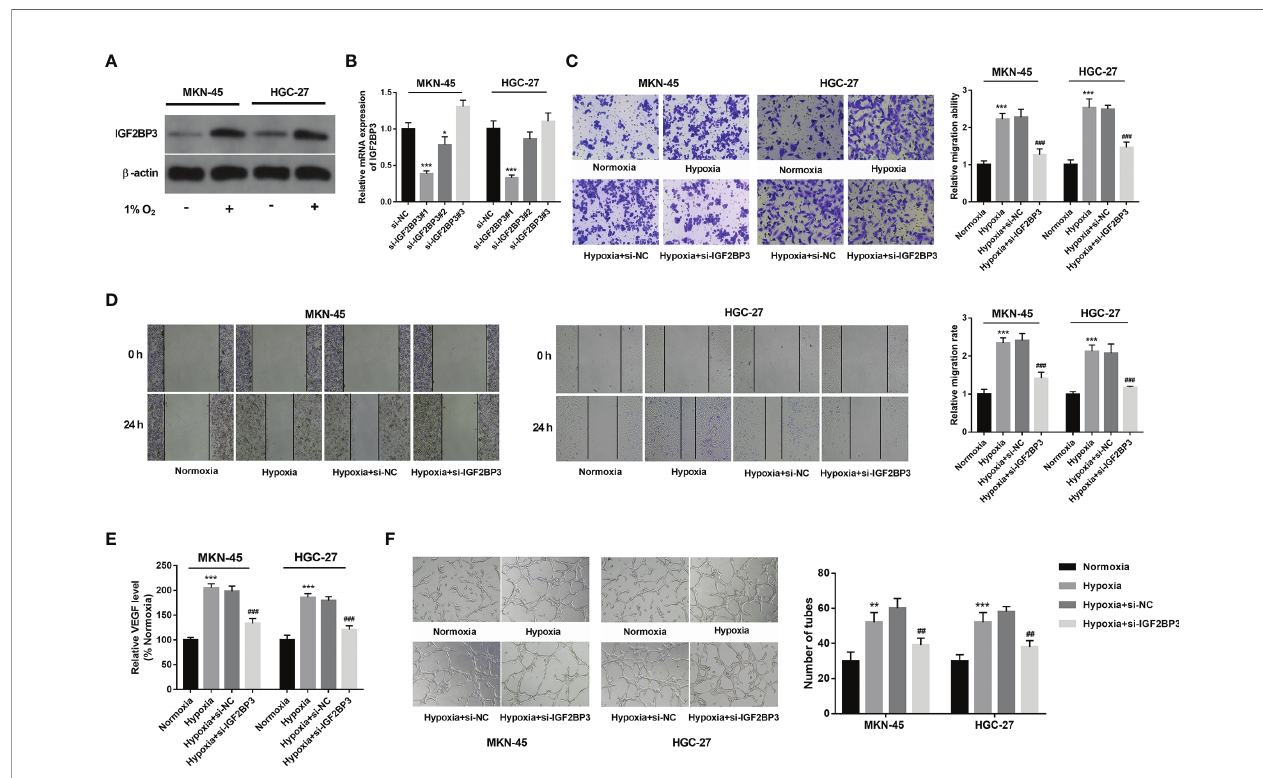
FIGURE 2 | IGF2BP3 knockdown hampered hypoxia-induced cell migration and angiogenesis in SC. (A) MKN-45 and HGC-27 cells were cultured in normoxic or hypoxic conditions for 24 h Next, the IGF2BP3 protein level was measured by western blot assay. (B) MKN-45 and HGC-27 cells were transfected with si-NC, si-IGF2BP3#1, si-IGF2BP3#2, or si-IGF2BP3#3. Next, the IGF2BP3 mRNA level was measured by RT-qPCR assay at 48 h after transfection. (C – F) MKN-45 and HGC-27 cells were transfected with si-NC or si-IGF2BP3#1 for 48 h and then maintained in hypoxic conditions for another 24 h Cells in the normoxia group were maintained in normoxic conditions for 72 h Cells in the hypoxia group were cultured in normoxia for 48 h and then exposed to hypoxia for an additional 24 h (C, D) Cell migratory potential was assessed by Transwell migration (C) and wound healing (D) assays. (E) VEGF level in cell culture supernatants was detected using a commercial kit. (F) The conditioned medium of MKN-45 and HGC-27 cells were collected after normoxia/hypoxia treatment or/and transfection. Next, HUVECs were cultured in a mixed medium of ECM and conditioned medium (volume ratio=1:1), followed by the measurement of tube formation ability at 12 h after incubation. * indicate that the difference is signi fi cant at 0.05 level. ** p < 0.01, *** p < 0.001, ## p < 0.01, ### p < 0.001 compared with the normoxia